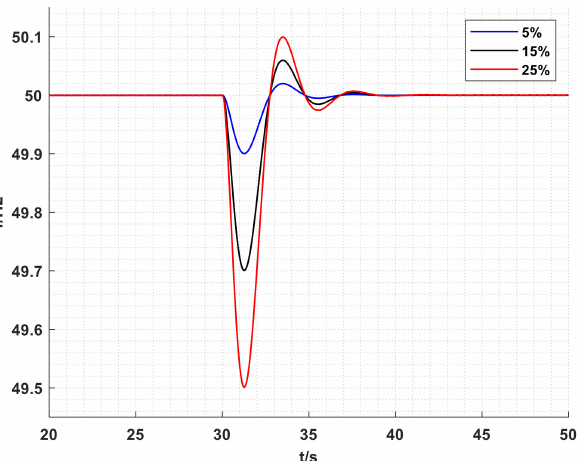
Figure 11. Frequency variation caused by different penetration rates of wind turbine and PV consid- ering the secondary FM.